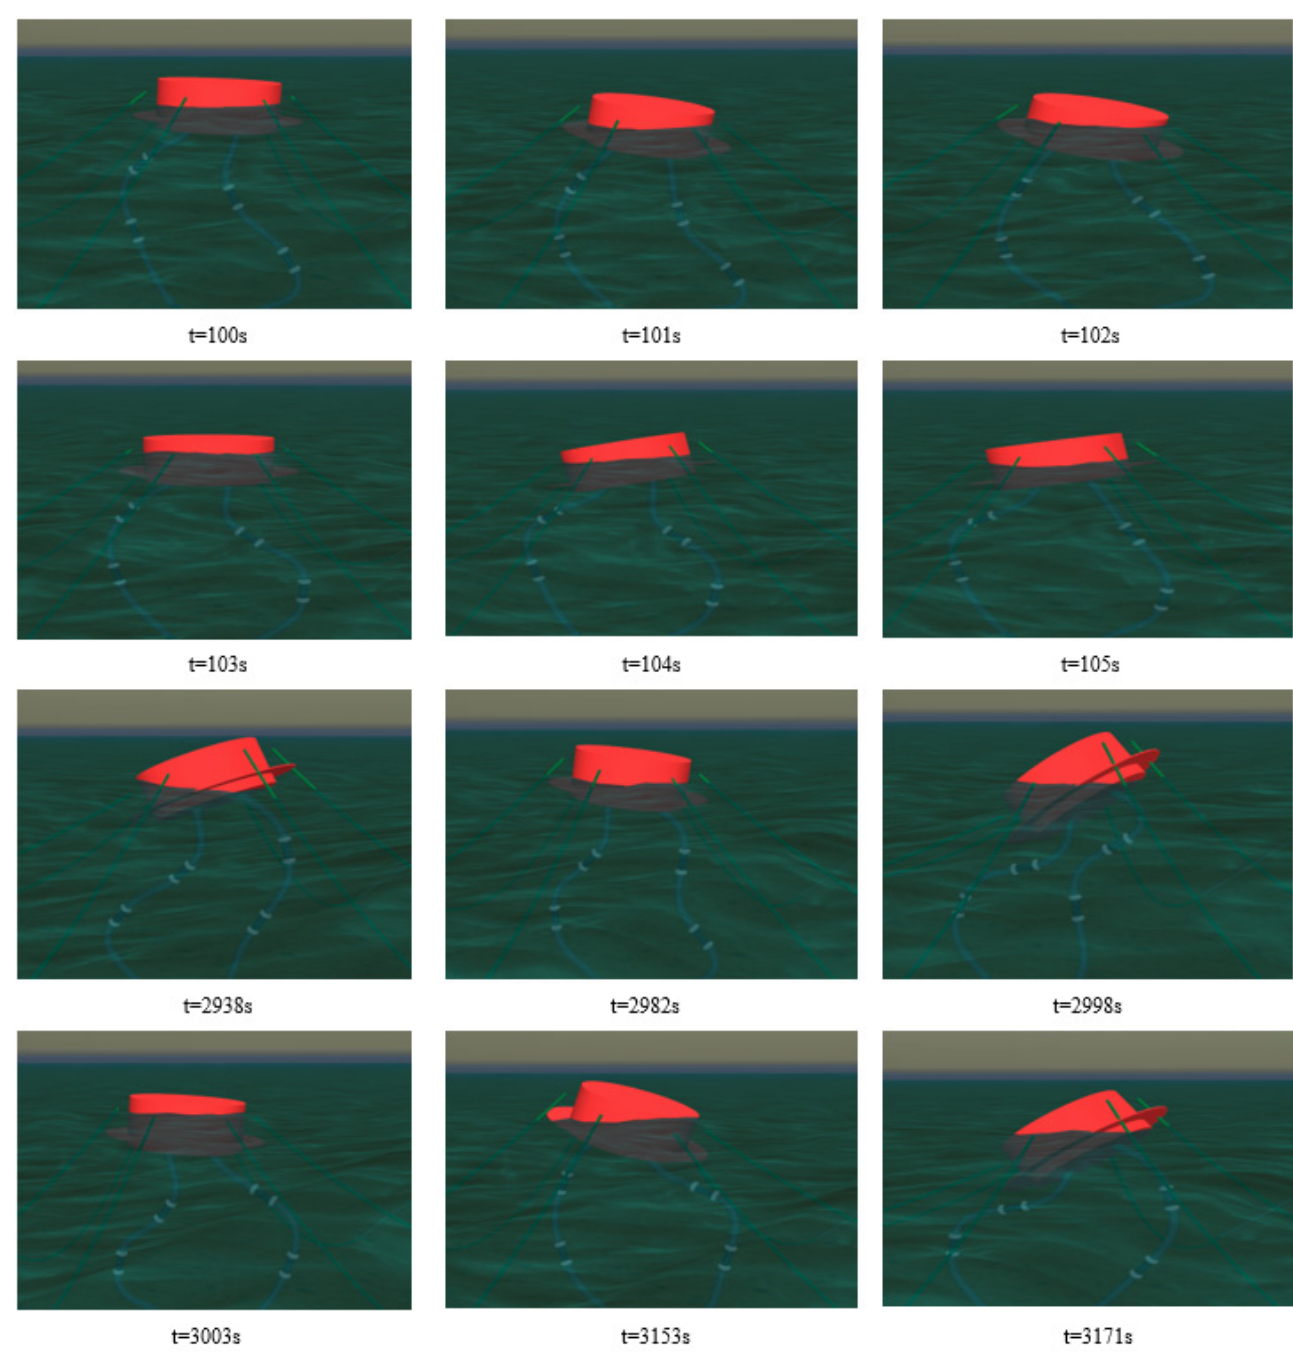
◦ flow s = 1.87 m, T z = 4.10 s, 0